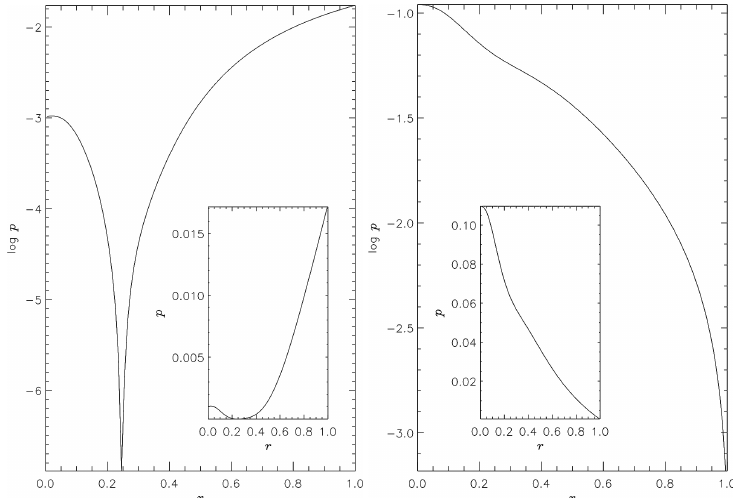
= 0.97, B φ = 1.58 × 10 − 3 ( left panel ), 2.81 ( right panel ), R j j ,m